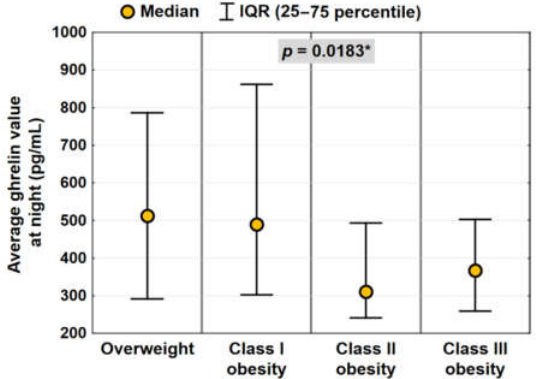
Figure 4. Night levels of ghrelin in subgroups classified according to BMI values (statistically significant correlation is marked using *). IQR—interquartile range. Table 4. Average median values (and ranges) of appetite-regulating hormones in patients with and without obstructive sleep apnea. OSA—obstructive sleep apnea. OSA Group Control Group Ghrelin (pg/mL) p = 0.05 Leptin (ng/mL) p = 0.19 Obestatin (pg/mL) p = 0.7